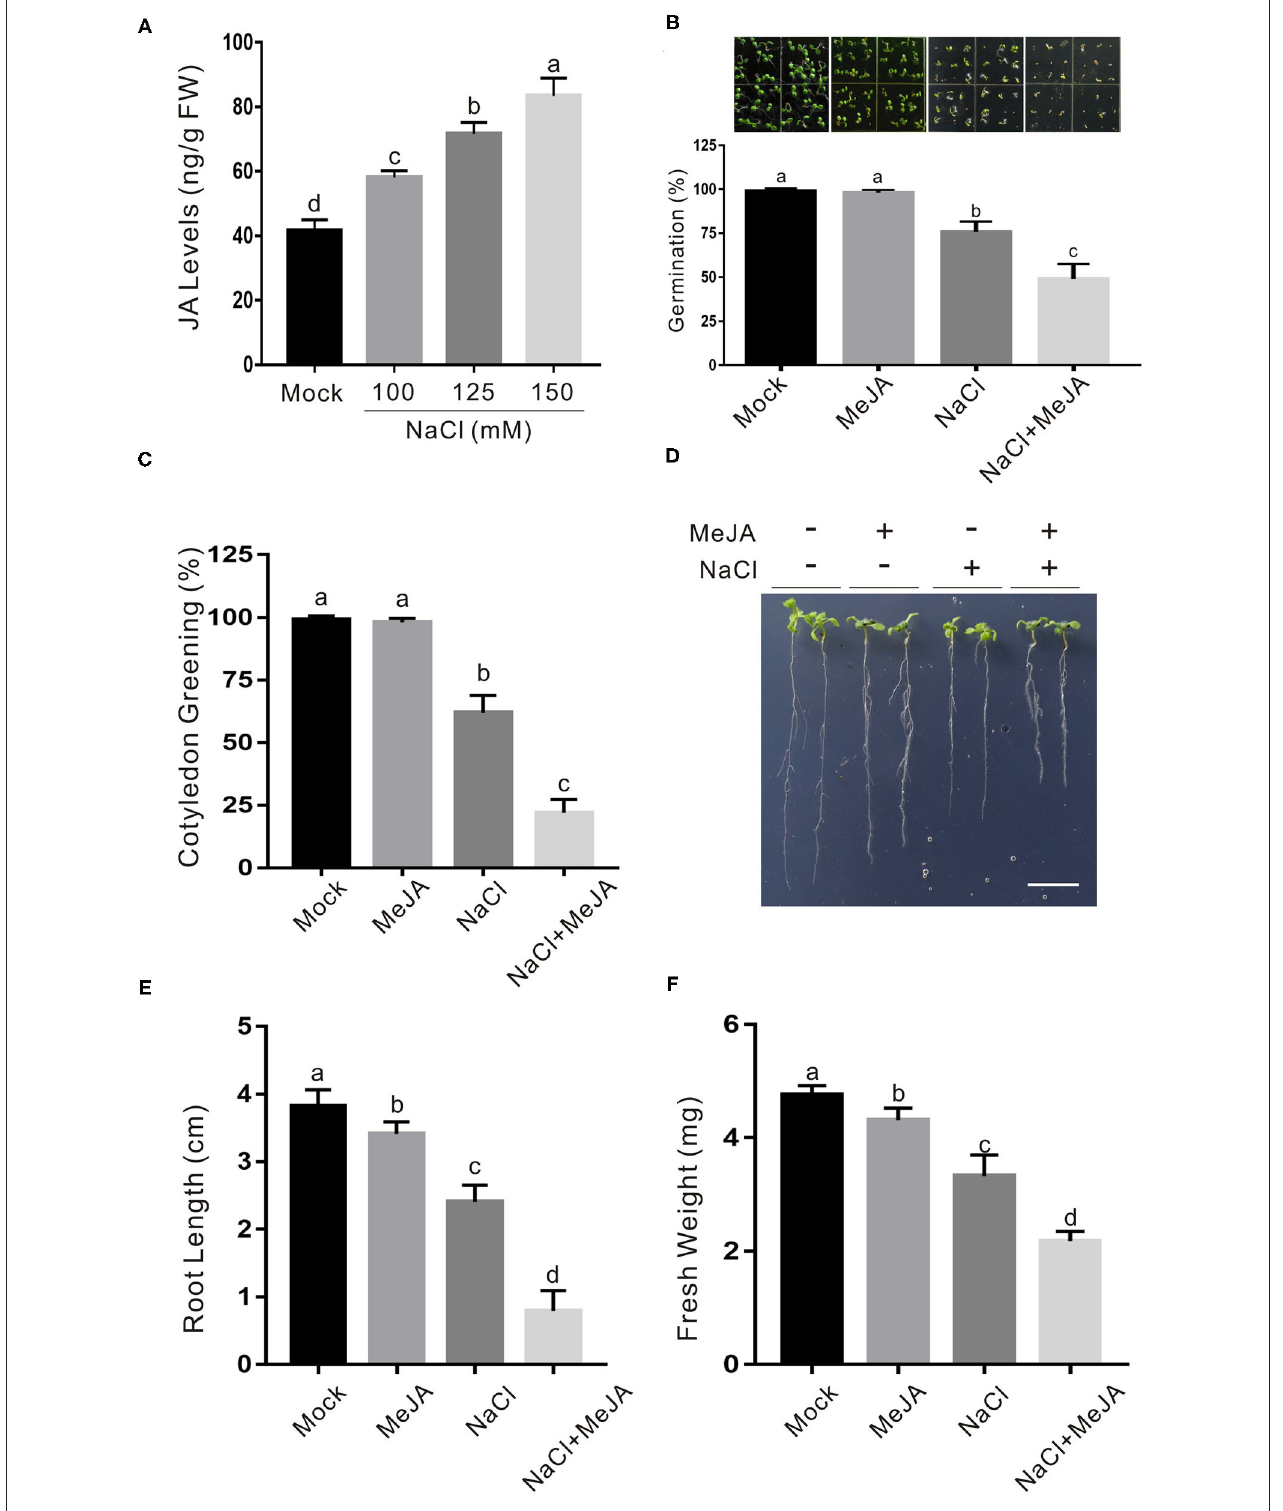
FIGURE 1 | JA increases plant sensitivity to salt stress. (A) JA levels in salt-treated or untreated wild-type plant seedlings. The 5-day-old wild-type plant seedlings were treated with 0, 100, 125, or 150mM NaCl for 5 days, and used for the determination of JA levels. Data are means ( ± SD) of three biological replicates. Bars